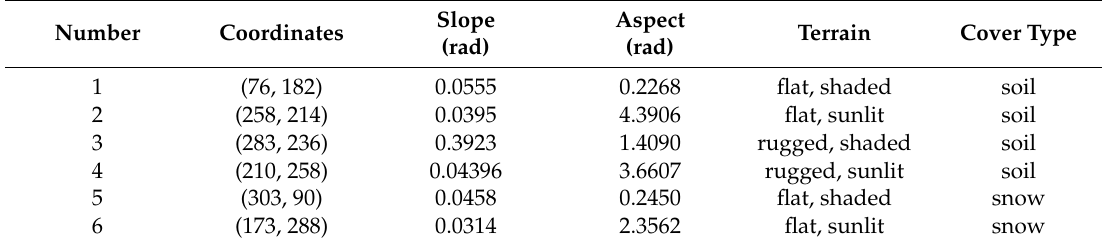
Table 2. Information about verification points.